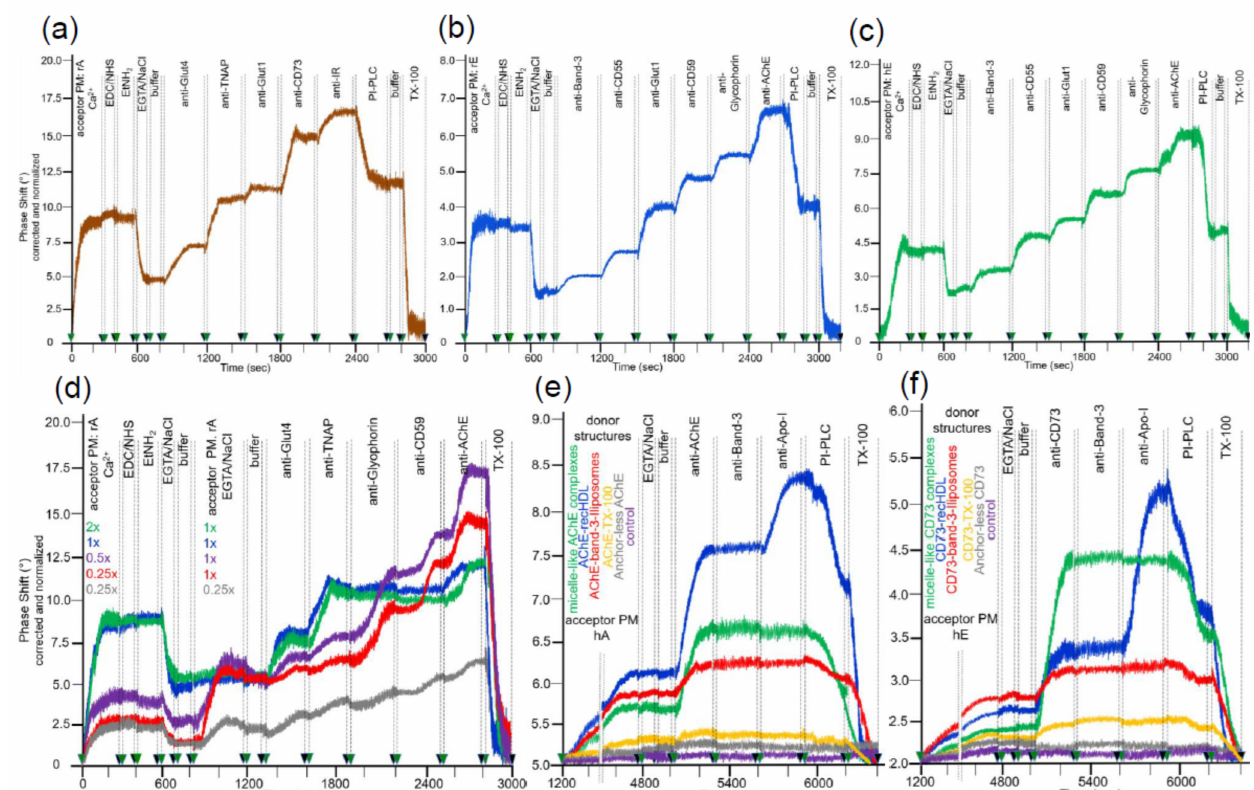
Figure 2. Capture of acceptor PM by SAW chip. PM from rat adipocytes ( a , d ), rat erythrocytes ( b ), human erythrocytes ( c , f ), and human adipocytes ( e ) were consecutively captured by chips via ionic (Ca 2+ ) and covalent bonds (EDC/NHS, EtNH 2 ; shown only for ( a – d ). ( a – c ) Characterization of the protein composition of the captured acceptor PM. Following consecutive injection of 150 µ L of acceptor PM (0.15–0.20 mg protein/mL), 50 µ L of EDC/NHS, 100 µ L of 1 mM EGTA/2 M NaCl, and then 50 µ L of buffer each at a flow rate of 30 µ L/min, 75 µ L of antibodies against GPI-APs and transmembrane proteins, then 75 µ L of PI-PLC ( Bacillus cereus , 7.5 mU/mL), subsequently 25 µ L of washing buffer and finally 50 µ L of TX-100 (0.1%) each at a flow rate of 15 µ L/min were injected as indicated. ( d ) Demonstration of saturation of the chips with acceptor PM. After consecutive ionic and covalent capture of rat adipocyte PM (150 µ L) at varying concentration (1 × rel. concentration corresponded to 0.15–0.20 mg protein/mL) and then washing with EGTA/NaCl and subsequently washing buffer as performed for ( a – c ), 200 µ L of fresh rat adipocyte acceptor PM were injected at the concentration (see above) indicated in the presence of 1 mM EGTA/2 M NaCl, followed by antibodies against GPI-APs and transmembrane proteins and finally TX-100 (0.1%) as performed for ( a – c ). ( e , f ) Translocation of GPI-APs from sources other than PM into acceptor PM. 100 µ L of micelle-like bAChE complexes, AChE-recHDL, liposomes reconstituted with bAChE and Band-3, AChE reconstituted into TX-100 detergent micelles, anchorless AChE or buffer (control) were injected into chips with captured human adipocyte ( e ) or erythrocyte ( f ) PM (at 800–1200 s) at a flow rate of 15 µ L/min. Thereafter at 1200 s, the flow rate was set at 0 for 1 h (hatched double line). Following injection of 200 µ L of 1 mM EGTA/2 M NaCl and then 200 µ L of washing buffer each at a flow rate of 120 µ L/min, antibodies against GPI-APs and transmembrane proteins, subsequently PI-PLC and finally TX-100 (0.1%) were injected (see ( a – c ); but omission of final buffer injection) as indicated. ( a – f ) The measured phase shift is given upon correction for unspecific interaction (no acceptor PM) and normalization for variable capturing efficacy of different chips (i.e., for identical amounts of captured acceptor PM). The experiment was repeated once with similar results. Hatched lines with green and black arrows indicate start and termination, respectively, of cycles of fluid injection as